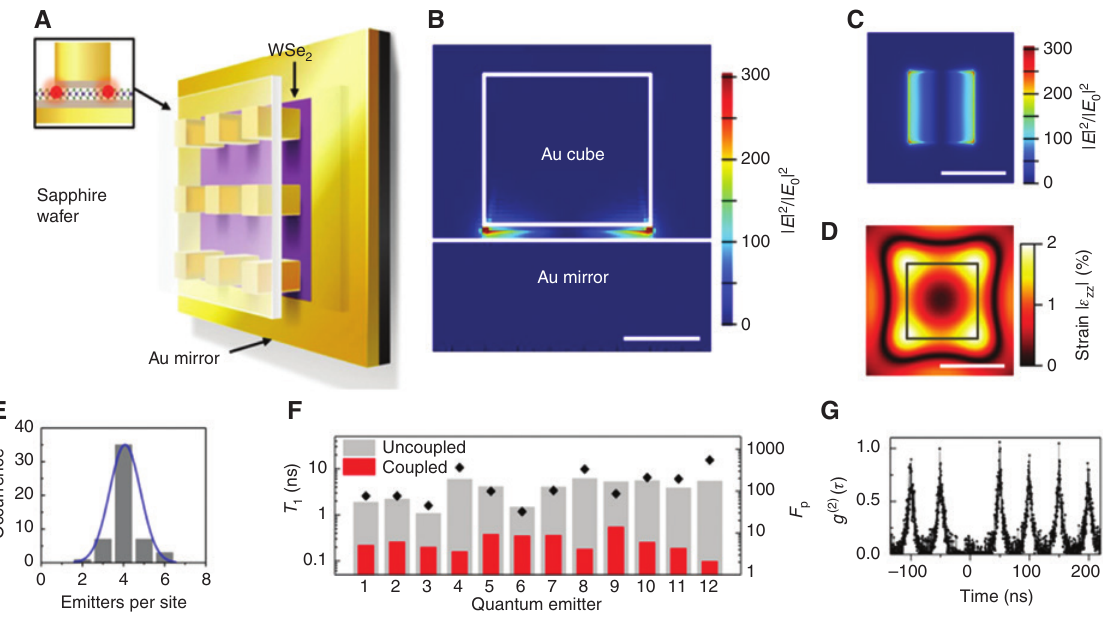
Figure 7: Quantum emitters coupled to plasmonic nanostructure. (A) Schematic of monolayer WSe coupled to a plasmonic Au nanocube cavity array. The WSe is separated from the plasmonic Au cubes 2 2 and the planar Au layer by a 2 nm Al O spacer layer on each side to prevent optical quenching and short circuiting of the nanoplasmonic 2 3 gap mode (depicted by gray shading in the inset). The transparent sapphire wafer allows the optical addressing of the quantum emitters. (B) Side view of the simulated intensity enhancement (|E| 2 / |E | 2 ) distribution profile illustrating the confinement of the plasmon across the 0 vertical gap containing the WSe . Scale bar, 50 nm. (C) Top view of simulated |E| 2 / |E | 2 showing four plasmonic hotspots at cube 2 0